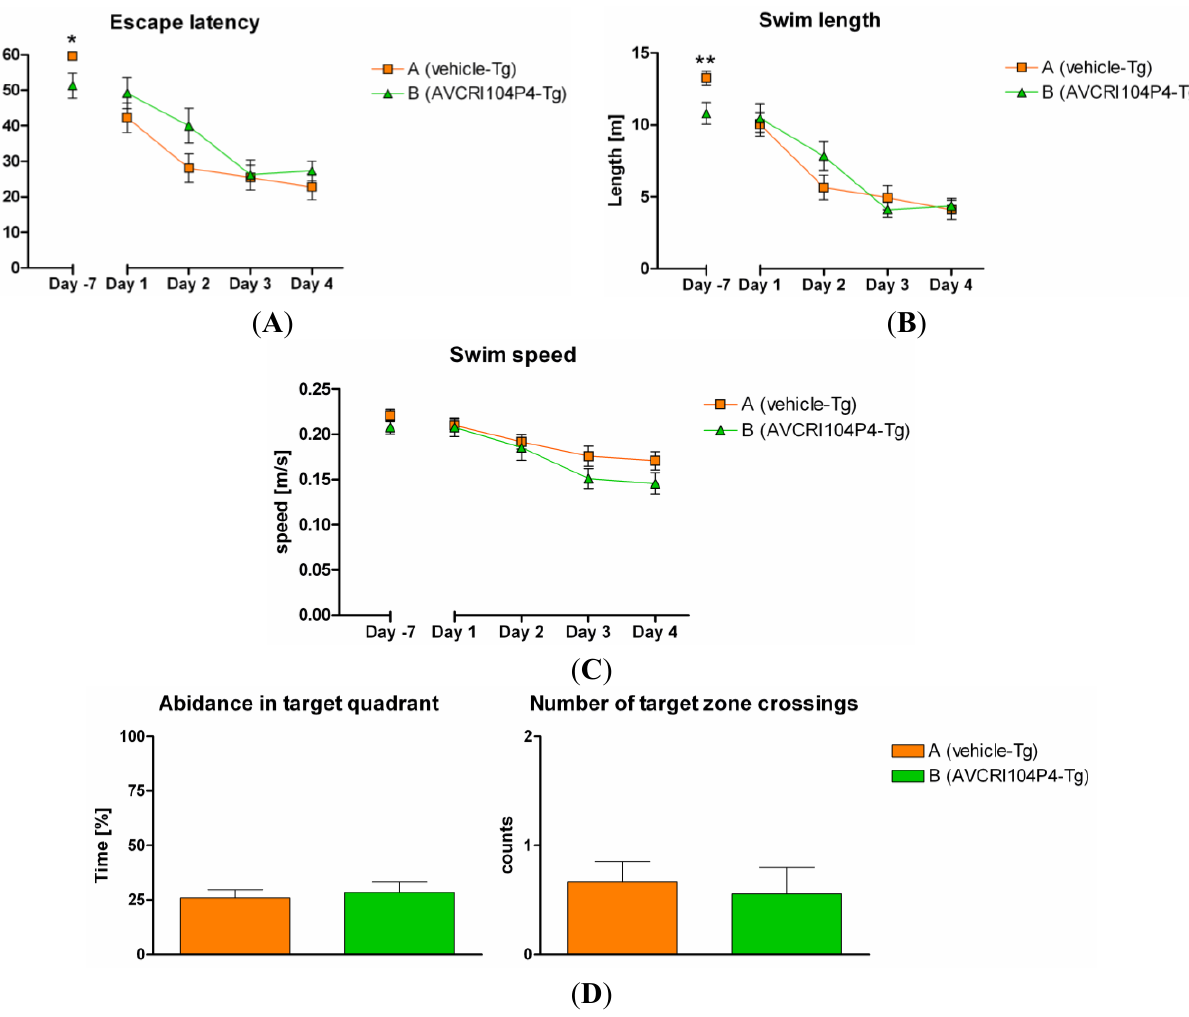
Figure 4. Graph represents ( A ) the latency to escape from the water (escape latency); ( B ) the swimming path to escape from the water (swim length); ( C ) the swim speed; and ( D ) the abidance in the target quadrant and number of target zone crossings in the MWM of hAPP SL transgenic animals treated with vehicle only (group A, orange) or AVCRI104P4 (group B, green) for 3 months. Data are presented as mean ± SEM for each treatment group and day. Statistical significant differences were detected on the very first training day (-7) using Mann-Whitney test (for (A)) or unpaired t-test (for (B)). * indicates p < 0.05. ** indicates p < 0.01. No statistical significant differences were detected for (C) and